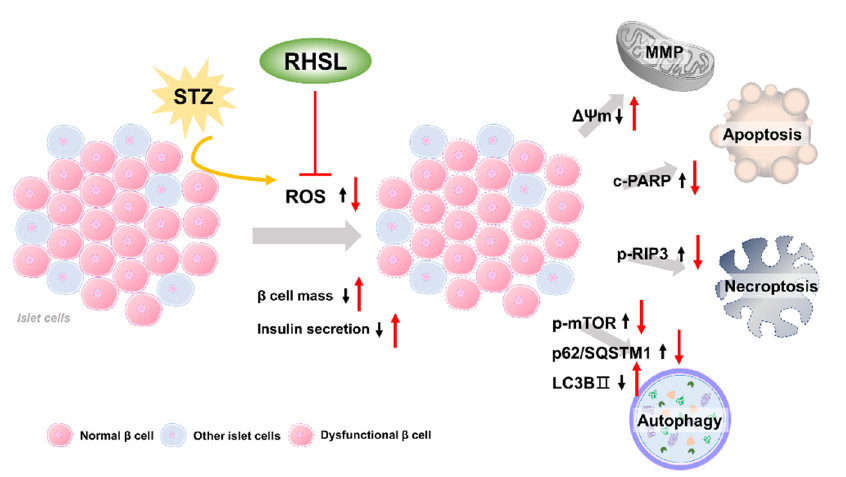
Figure 6. Schematic model of the potential mechanisms of RHSL protective effect on RIN-m5F cells from STZ-induced oxidative damage. Black arrows are the effects of STZ, red arrows are effects of RHSL. Abbreviation: RHSL, rice husk silica liquid; STZ, streptozotocin; ROS, reactive oxygen species; ∆Ψ m, mitochondria membrane potential; RIP3, receptor-interacting protein 3; PARP, poly (ADP-ribose) polymerase; mTOR, mammalian target of rapamycin; p62/SQSTM1, sequestosome-1; LC3, light chain 3.